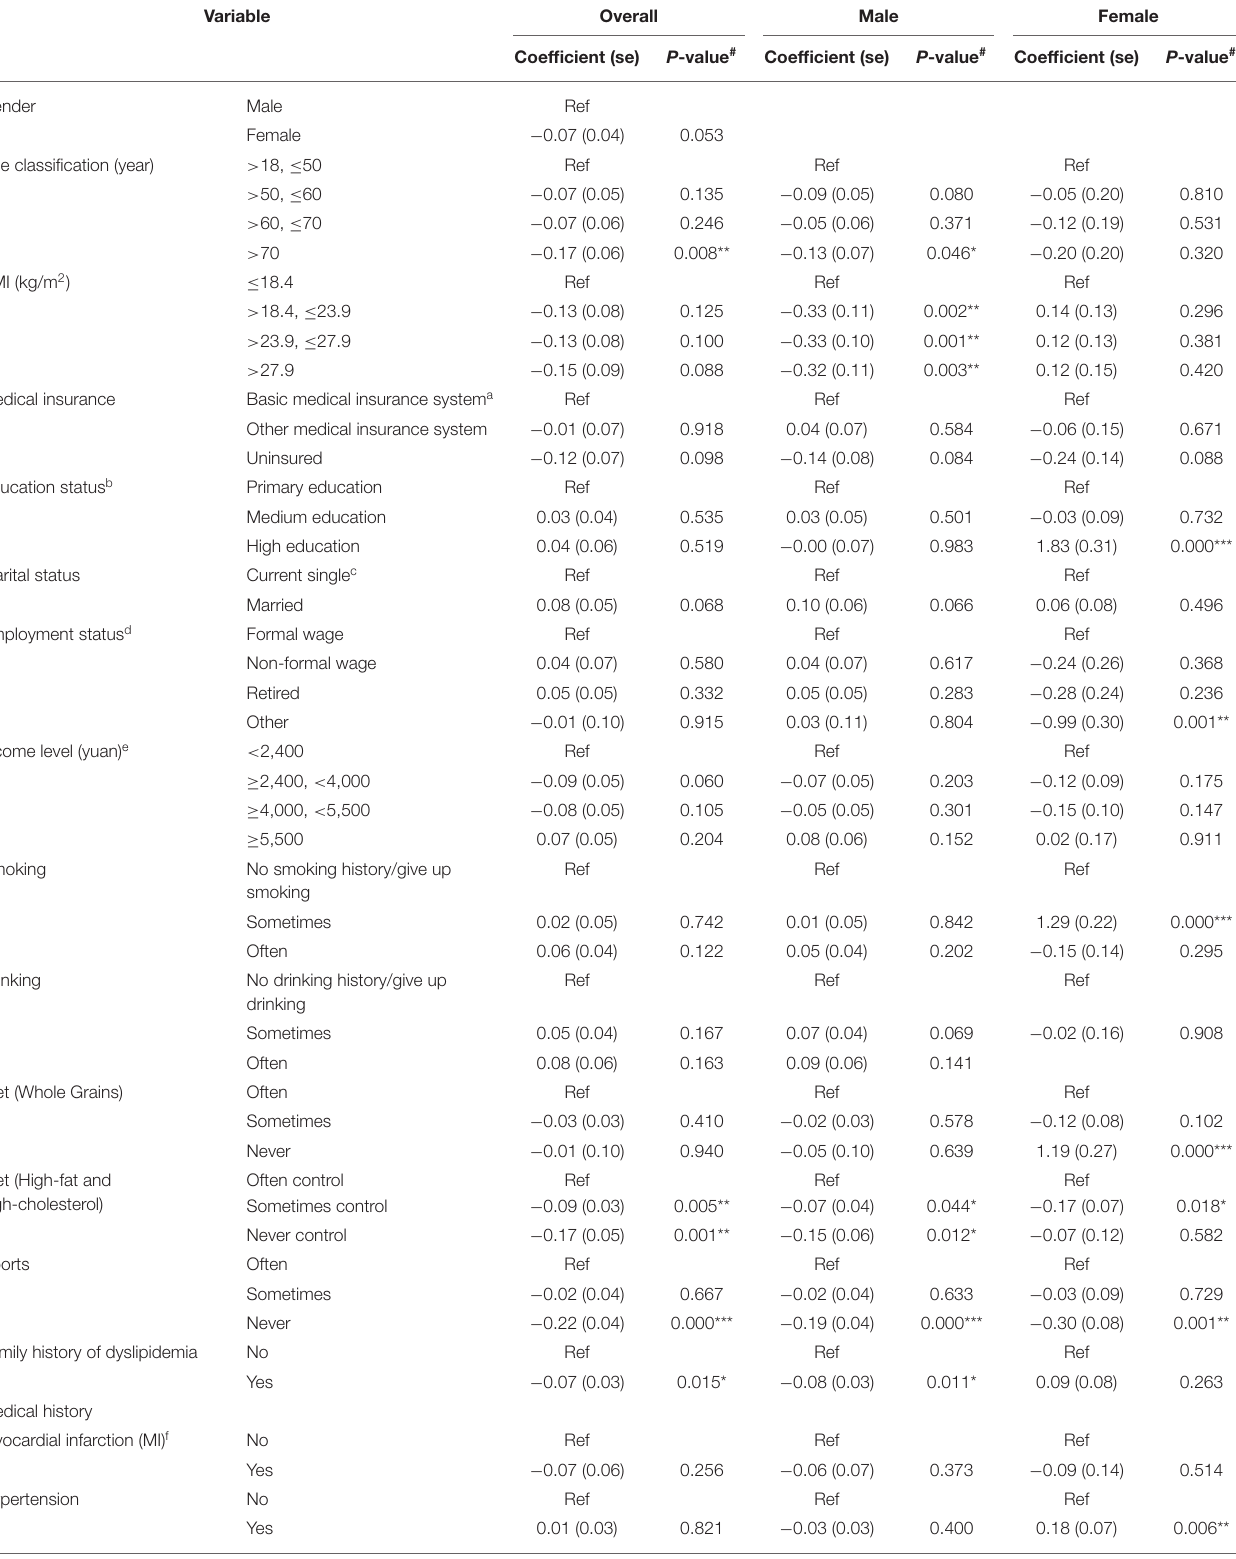
TABLE 2 | Tobit regression for EQ-5D